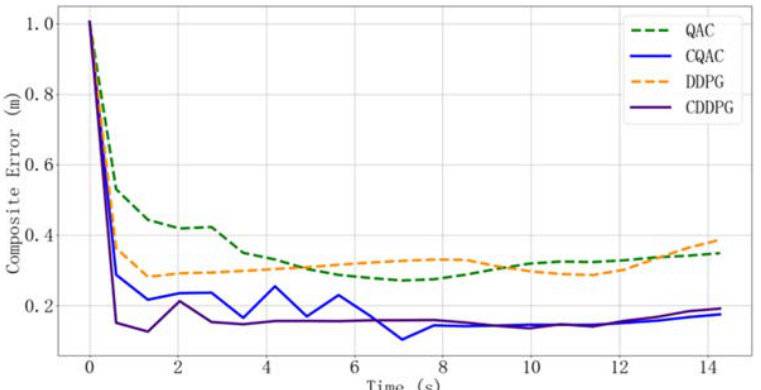
Figure 17. Compisite tracking error of uniform acceleration.